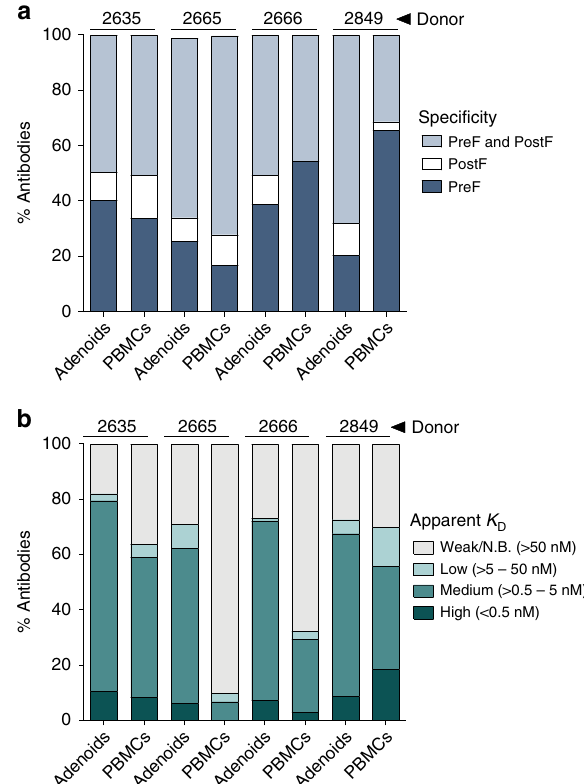
Fig. 3 Binding properties of RSV F-speci fi c antibodies isolated from adenoids and PBMCs. a Percentage of antibodies isolated from adenoids or PBMCs that are preF-speci fi c, preF/postF-cross-reactive, or postF-speci fi c ( n = 808 antibodies). b Percentage of antibodies isolated from adenoids or PBMCs with the indicated apparent af fi nities for preF ( n = 808